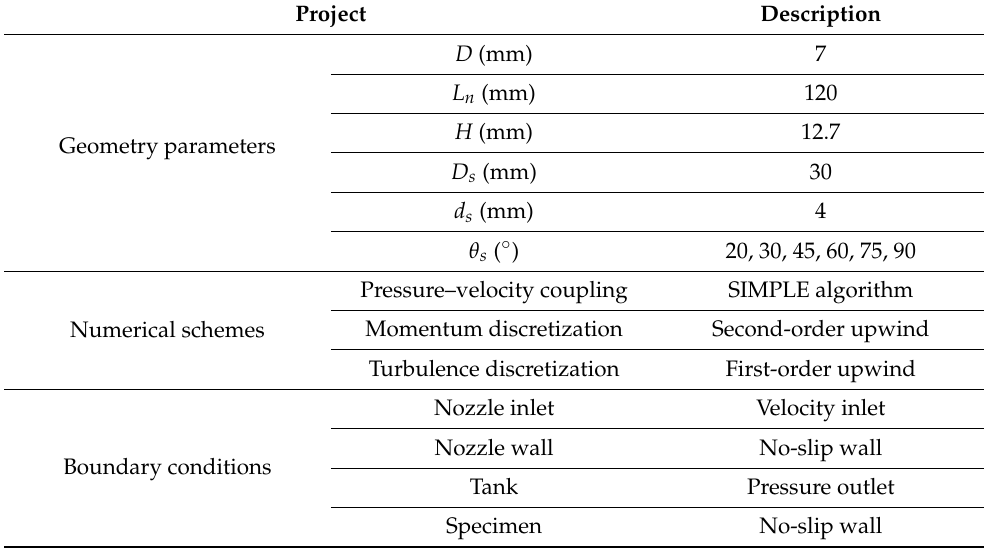
Table 2. Geometry features, numerical schemes, and boundary conditions in computational fluid dynamics (CFD).